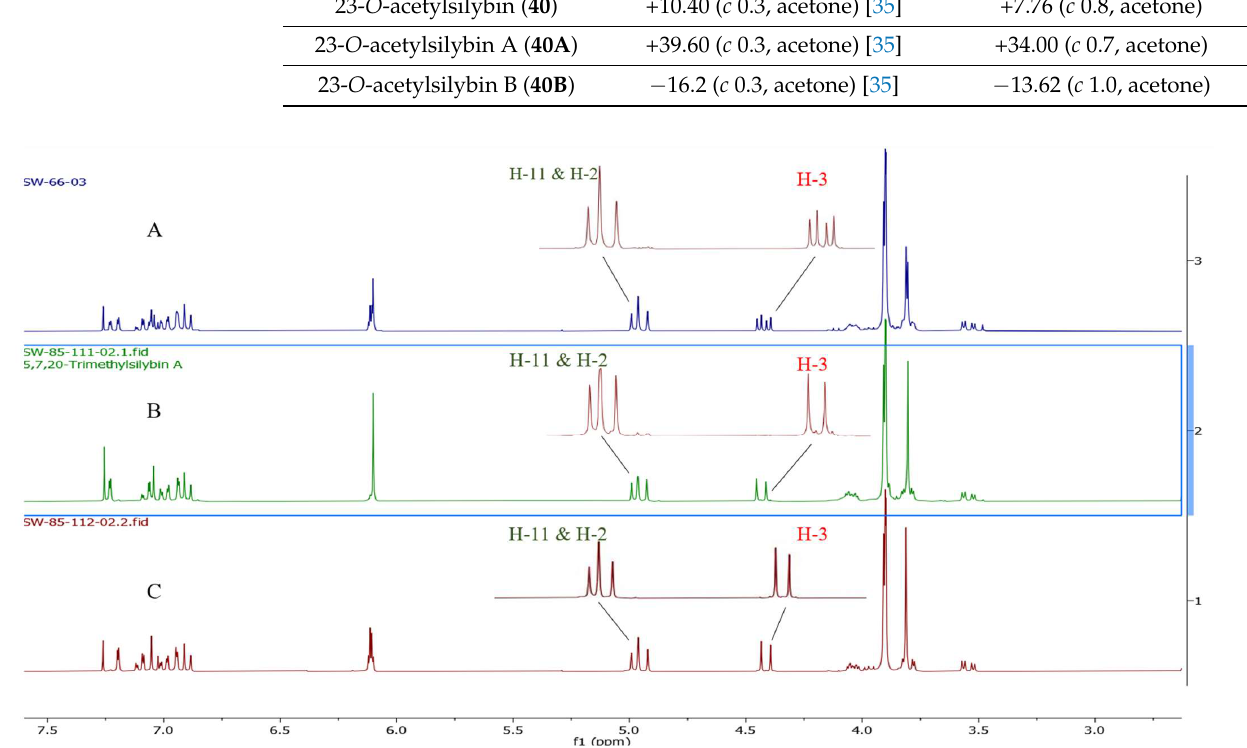
Figure 7. 1 H NMR of 5,7,20- O -trimethylsilybin. ( A ) 1 H NMR spectrum of diastereomeric mixture of 5,7,20- O -trimethylsilybin ( 5 ). ( B ) 1 H NMR spectrum of optical pure 5,7,20- O -trimethylsilybin A ( 5A ). ( C ) 1 H NMR spectrum of optical pure 5,7,20- O -trimethylsilybin B ( 5B ).